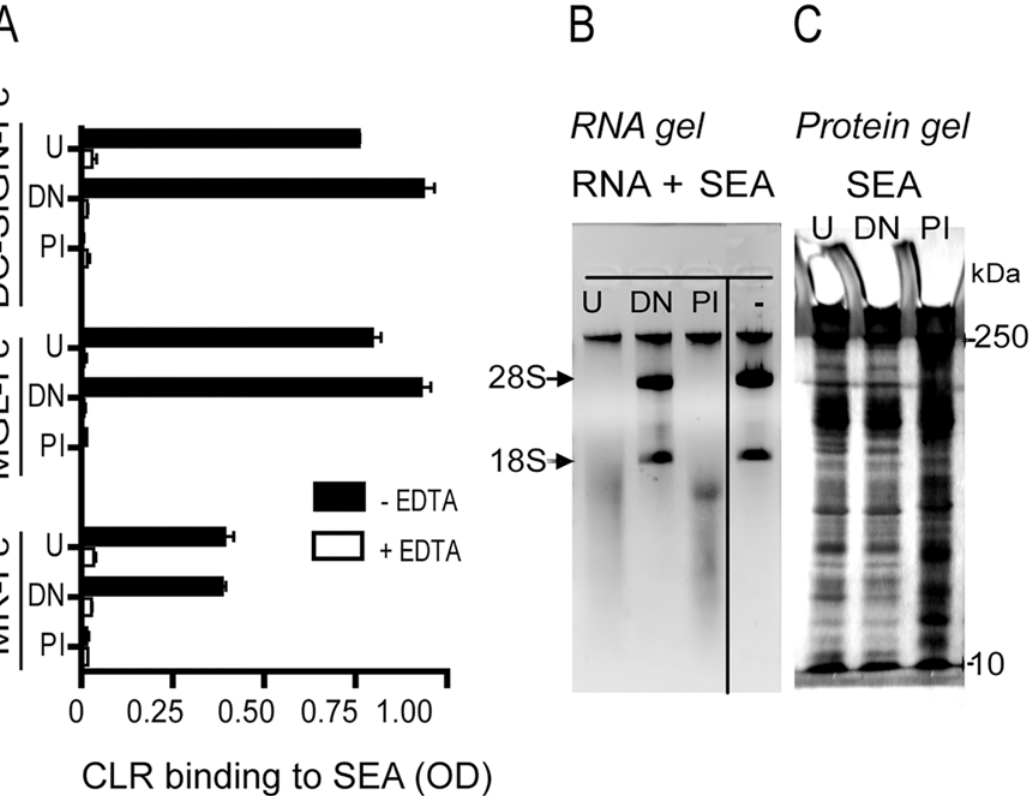
Fig 1. Treatments of S . mansoni SEA with periodate (PI) or heat (DN) results in modified glycan structures, or inactivation of RNase activity, respectively. A . Binding of IgG-Fc hybrid molecules of the C-type lectin receptors DC-SIGN, MGL and MR to untreated (U) SEA, SEA treated with 10 mM periodate (PI), or heated at 80°C for 20 min (DN) (coated at 5 μ g/ml) was assessed by ELISA. In addition, binding to SEA was evaluated in the presence of EDTA (5 mM), which prevents CLR binding by removing calcium. B . RNase activity of the differentially treated SEA was assessed using total RNA isolated from human dendritic cells. All SEA samples were incubated with RNA for 1h at 37°C and subsequently agarose gel electrophoresis was performed under RNase-free conditions to visualize degradation of the RNA. The position of the 28S and 18S ribosomal units in the gel are indicated by arrows. C . Silver staining of an SDS-PAGE protein gel loaded with SEA U, DN and PI (10 μ g/ml). The position of 10 and 250kD molecular weight markers on the gel are indicated by arrows. The data shown are typical examples out of 3 independent experiments.